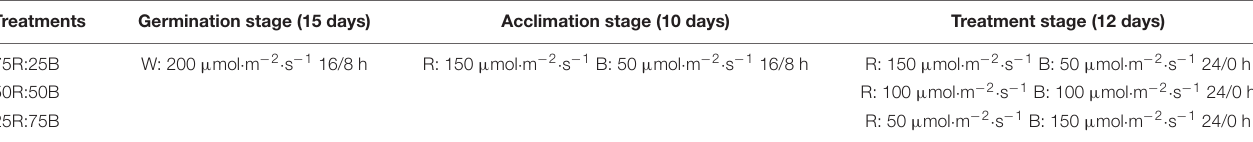
TABLE 1 | Light spectrum, light intensity, and photoperiod of each treatment at each growth stage of lettuce. W: white LED light, R: red LED light, B: blue LED light. Treatments Germination stage (15 days) Acclimation stage (10 days) Treatment stage (12 days)